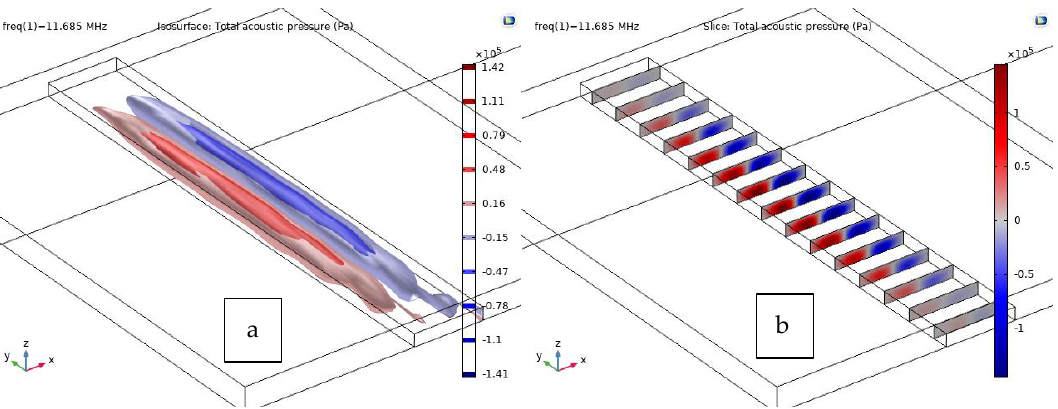
Figure 4. Acoustic pressure distribution within the fluid domain: ( a ) pressure iso-surfaces, ( b ) pressure distribution sliced by parallel planes.